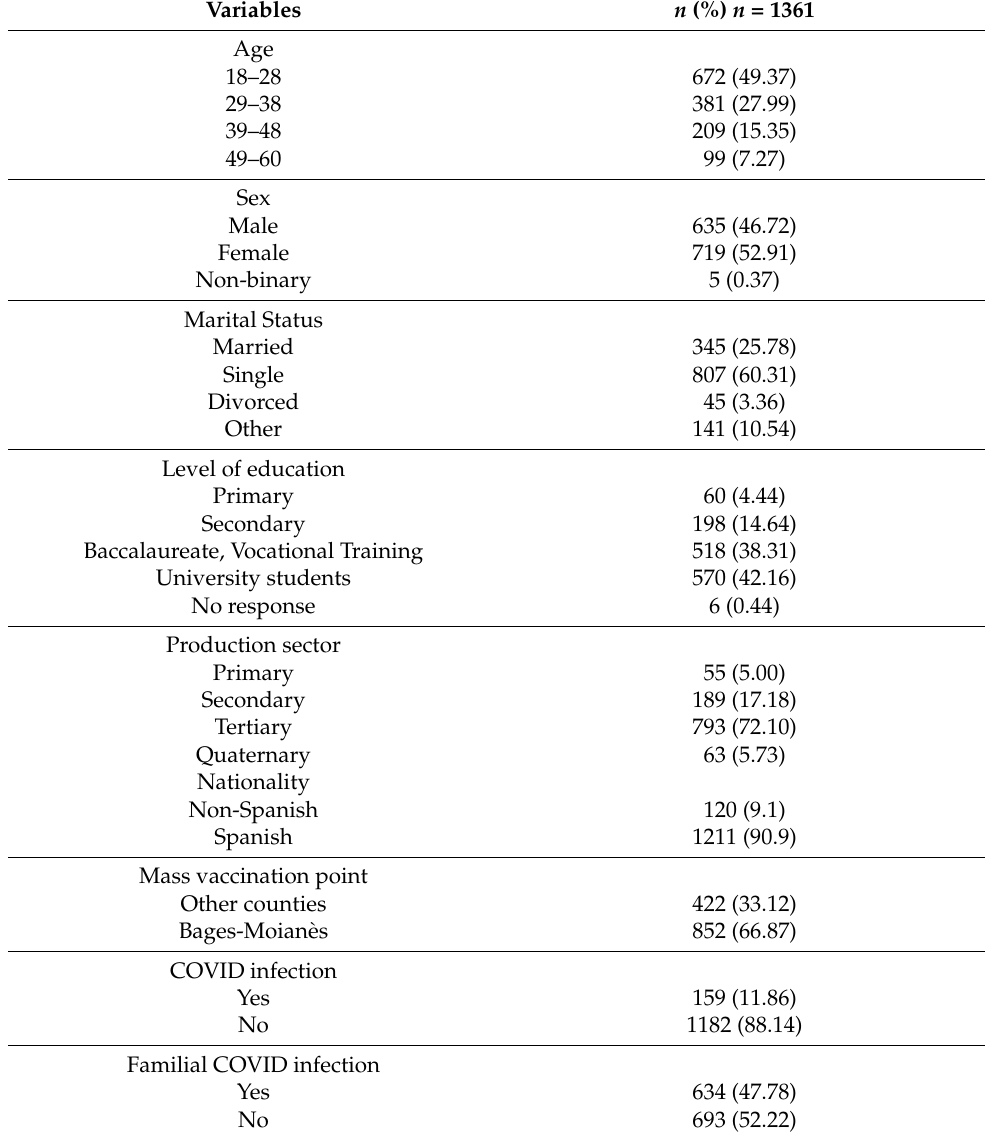
Table 1. Descriptive analysis of the